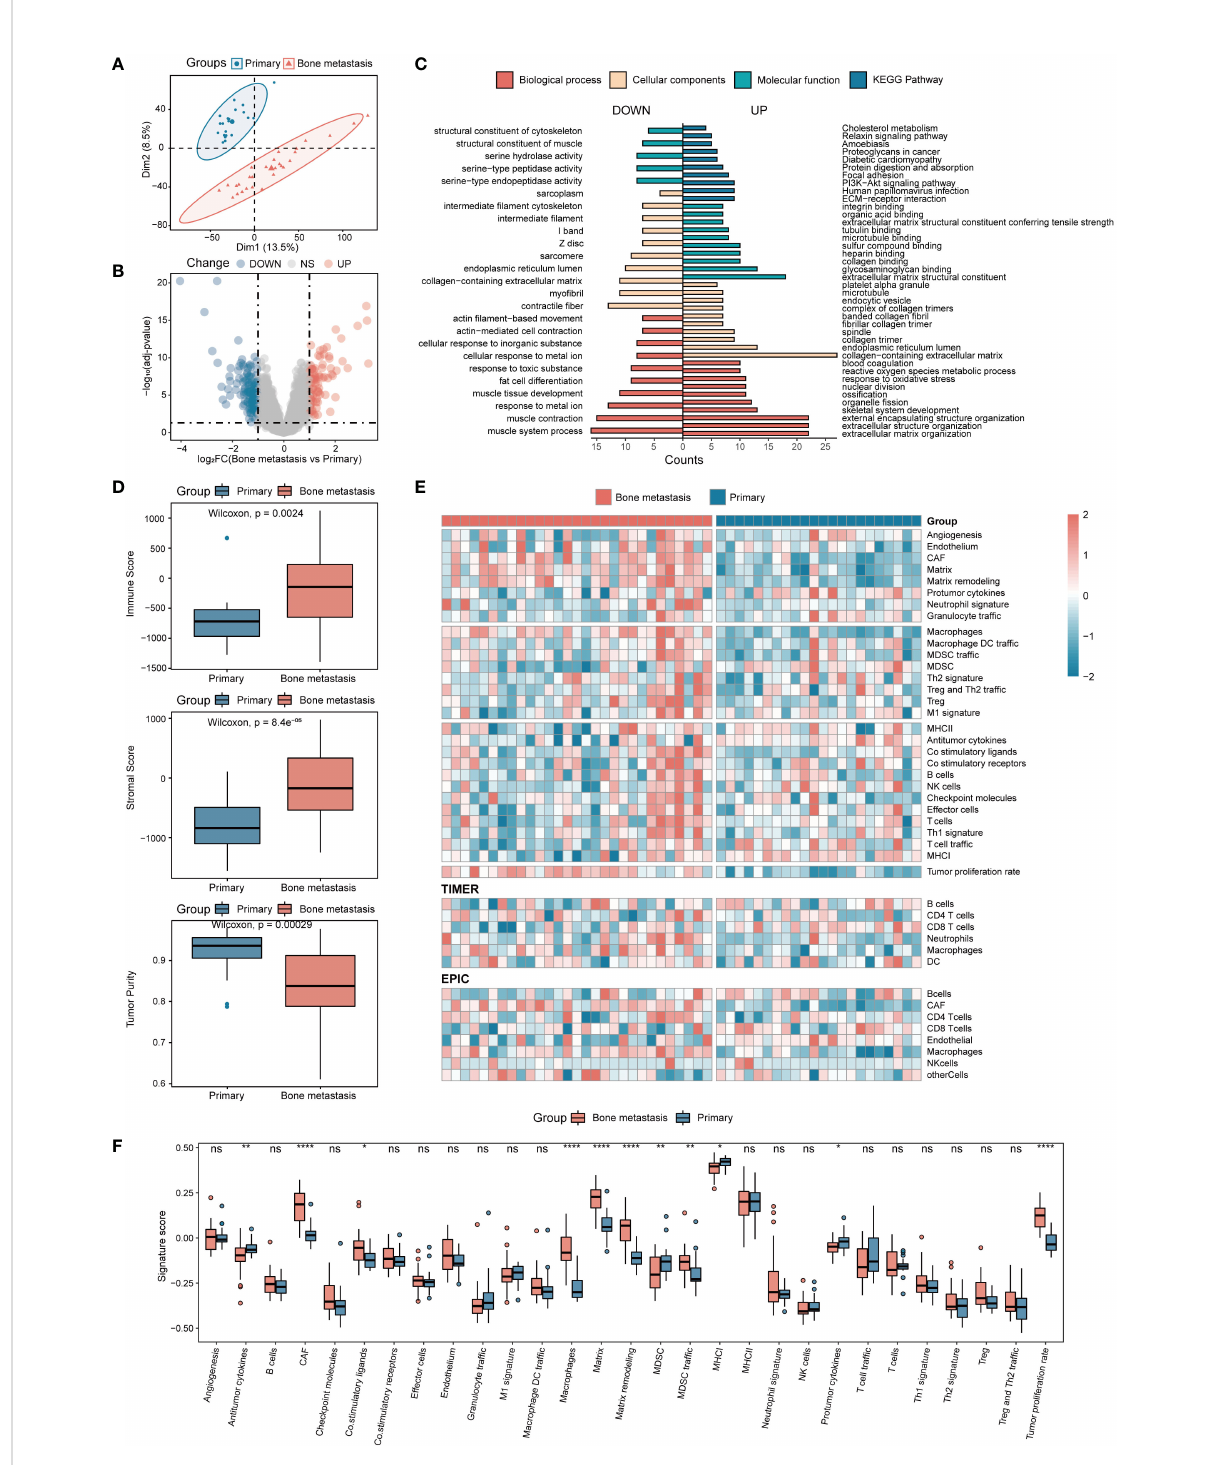
FIGURE 1 Analysis of DEGs and immune in fi ltration in CRPC with BMs. (A) Sample principal component analysis. (B) Analysis of DEGs in BMs. (C) DEGs of BMs enrichment analysis. (D) Immune, stromal, and tumor purity scores in patients between the primary focus and BMs. (E) Immune in fi ltration analysis. (F) Twenty-nine immune cell characteristics in patients with BMs. *P<0.05; **P<0.01; ****P<0.0001. ns, not signi fi